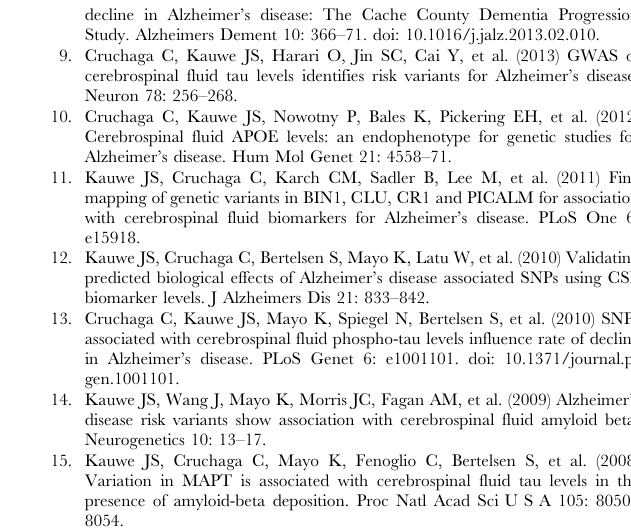
Figure S2 Manhattan plots for CCL2. The x-axis shows each marker that was analyzed, sorted by chromosome and position. The y-axis shows the 2 log 10 of the p-value for association with the respective phenotype. Figure S3 Manhattan plots for CCL4. The x-axis shows each marker that was analyzed, sorted by chromosome and position. The y-axis shows the 2 log 10 of the p-value for association with the respective phenotype. Figure S4 Manhattan plots for IL6R. The x-axis shows each marker that was analyzed, sorted by chromosome and position. The y-axis shows the 2 log 10 of the p-value for association with the respective phenotype. Figure S5 Manhattan plots for MMP3. The x-axis shows each marker that was analyzed, sorted by chromosome and position. The y-axis shows the 2 log 10 of the p-value for association with the respective phenotype. Table S1 All study-wide significant variants. For each marker the chromosome (CHR), base pair position (BP), Alleles (Allele1, Allele2), p-value from the ADNI dataset (ADNI), p-value from the Knight ADRC dataset (Knight ADRC), combined sample p-value (Combined), direction of association (Direction), minor allele frequency (MAF), Genotyping status, function, Nearest Genes, exonic function, amino acid change and regulome score is provided. Table S2 Association of CSF ACE, IL6R, CCL4, MMP3 and CCL2 levels with age and gender. The slope and p-value for linear regression with age and gender is shown for the ADNI and KADRC samples. P-values of less than 0.05 are shown in bold. Table S3 Association of plasma ACE, IL6R, CCL4, MMP3 and CCL2 levels with age and gender. The slope and p-value for linear regression with age and gender is shown for the ADNI and KADRC samples. P-values of less than 0.05 are shown in bold.